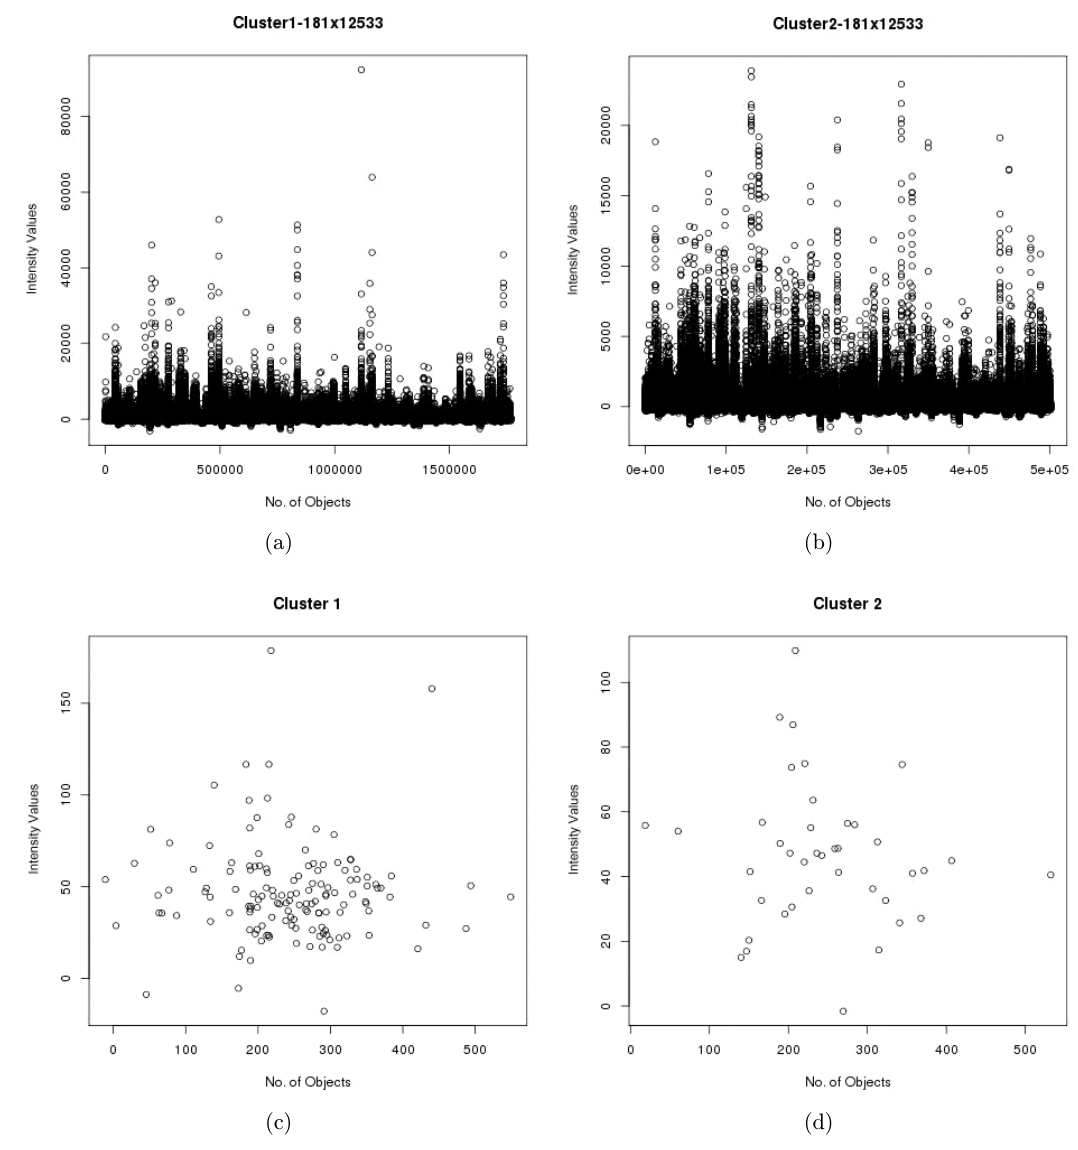
Fig. 11. Subtype of Cancers by KFCM nt : (a) Gene expression in Cluster 1 (b) Gene expression in Cluster 2 (c) Cluster 1 in 181 Lung Cancer dataset (d) Cluster 2 in 181 Lung Cancer